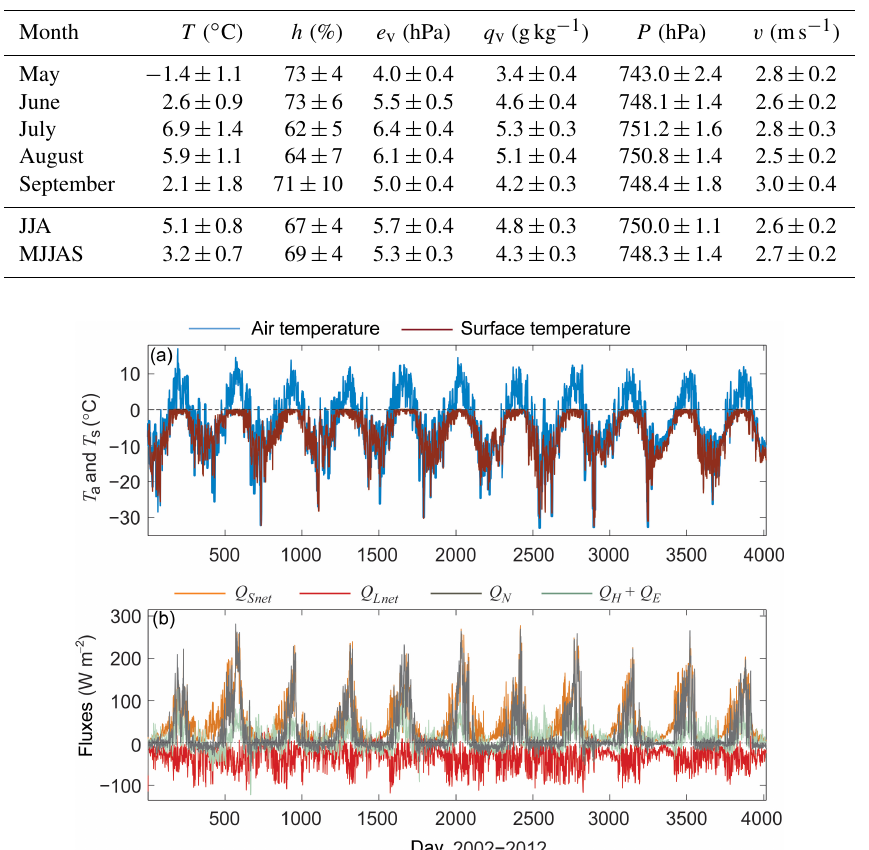
Figure 3. The 11-year record of (a) air temperature, modelled surface temperature, and (b) surface energy fluxes at the Haig Glacier AWS site. Daily mean values are plotted from 1 January 2002 to 31 December 2012.